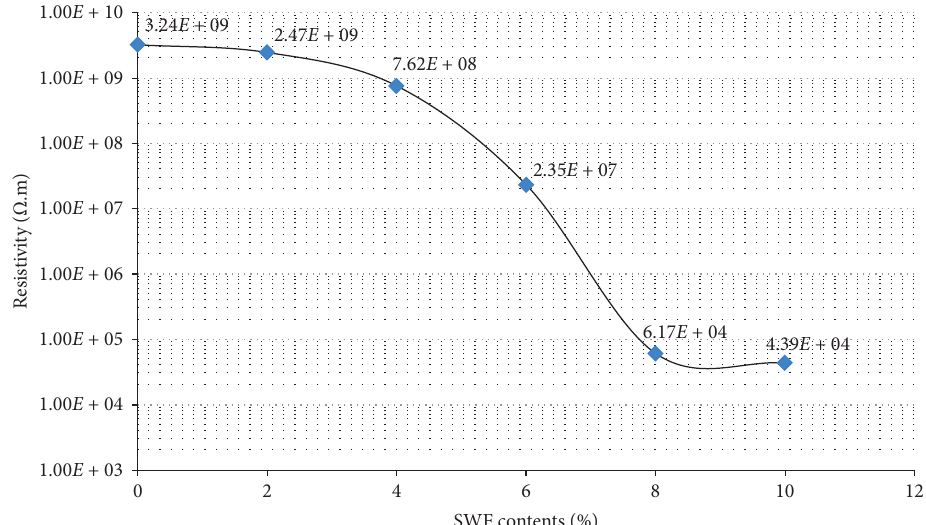
Figure 6: Changes in electrical resistance of SWF modified mixtures relative to SWF